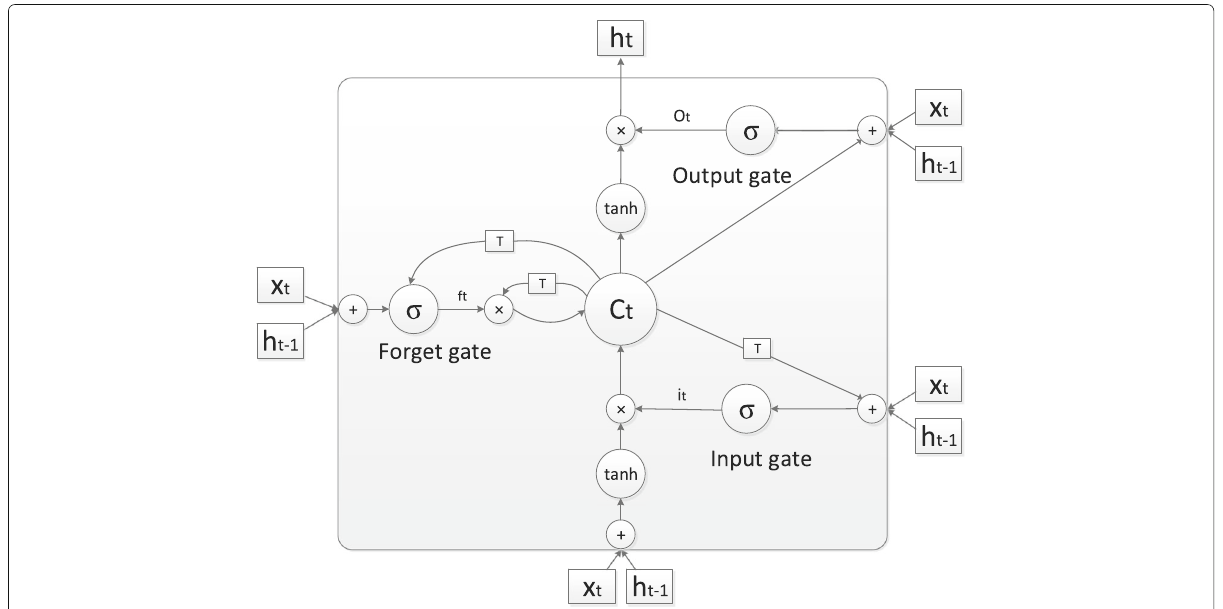
Fig. 1 Long short-term memory unit. “T” denotes a delay of one time step, σ denotes the sigmoid function, and “tanh” denotes hyperbolic tangent